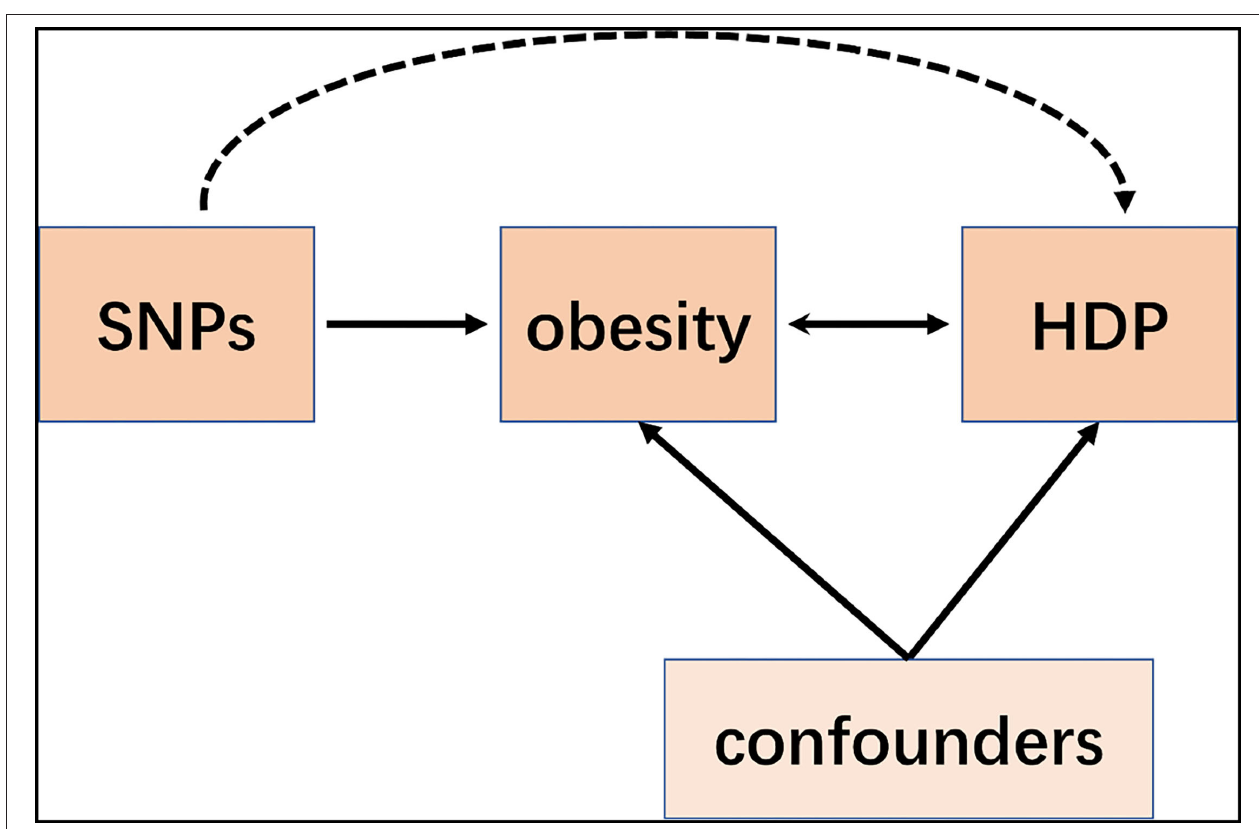
FIGURE 1 | Schematic representation of an MR analysis. We selected SNPs which associated with obesity and the corresponding effect for these SNPs was estimated based on the risk of HDP obtained from a large cohort of the European